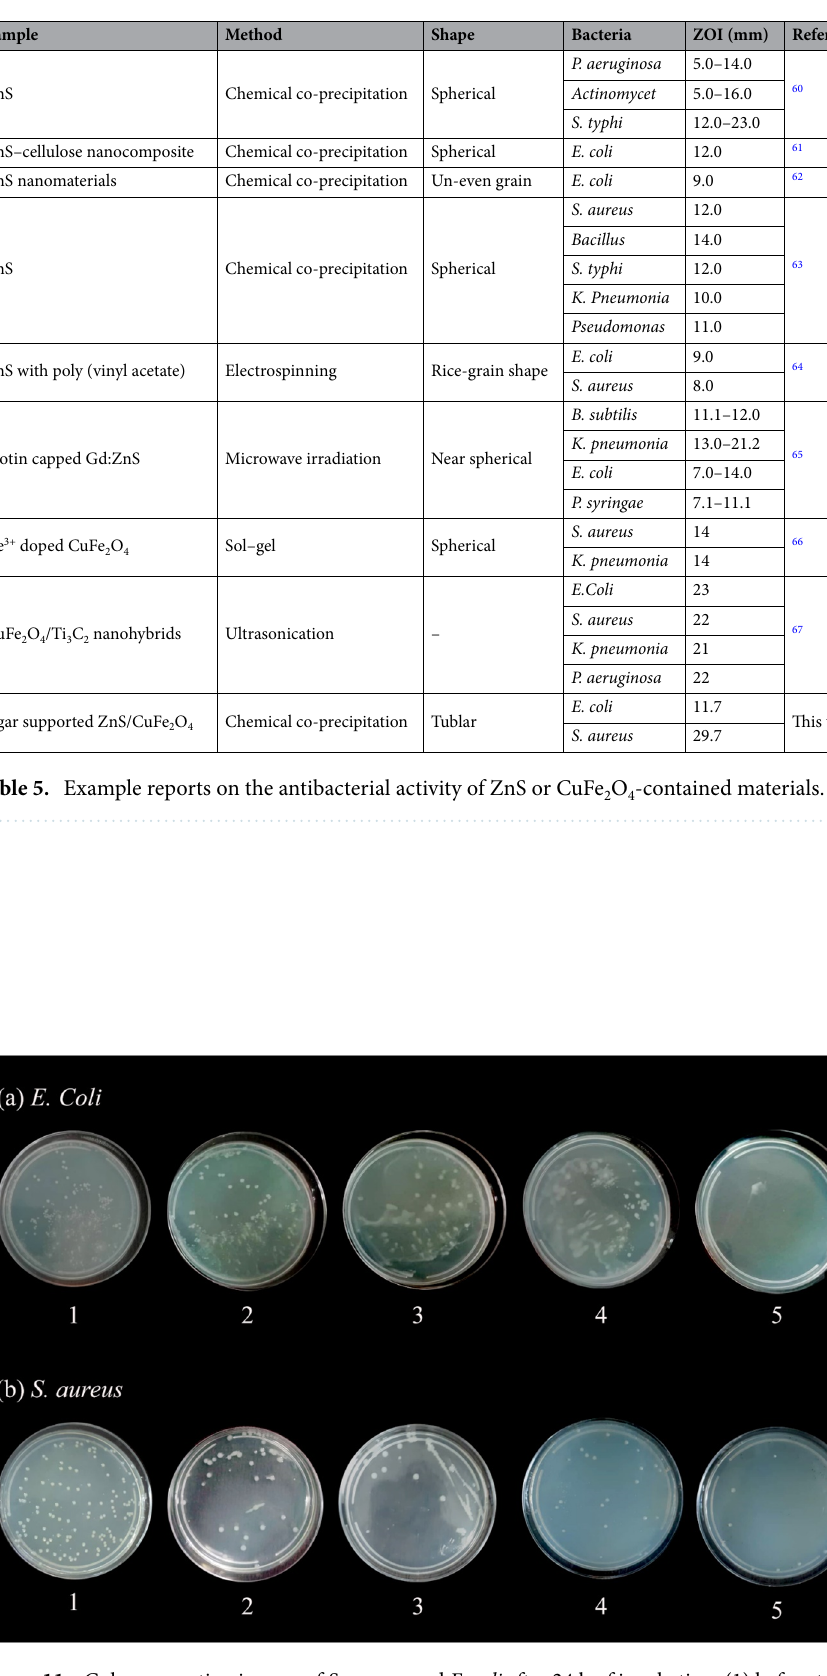
Figure 11. Colony counting images of S. aureus and E. coli after 24 h of incubation, (1) before treatment (control plate), after treatment with (2) agar, (3) ZnS, (4) CuFe 2 O 4 and (5) agar supported ZnS/CuFe 2 O 4